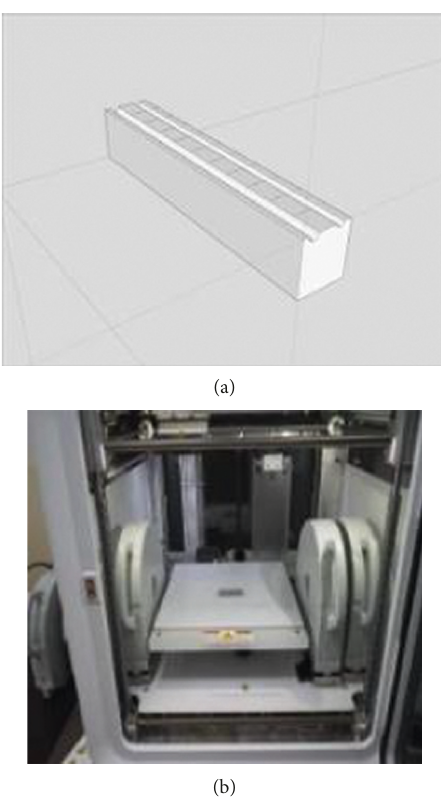
Figure 1: Jig 3D printing for light delivery measurement of unbent POF. (a) Jig design using Google SketchUp. (b) 3D-printed